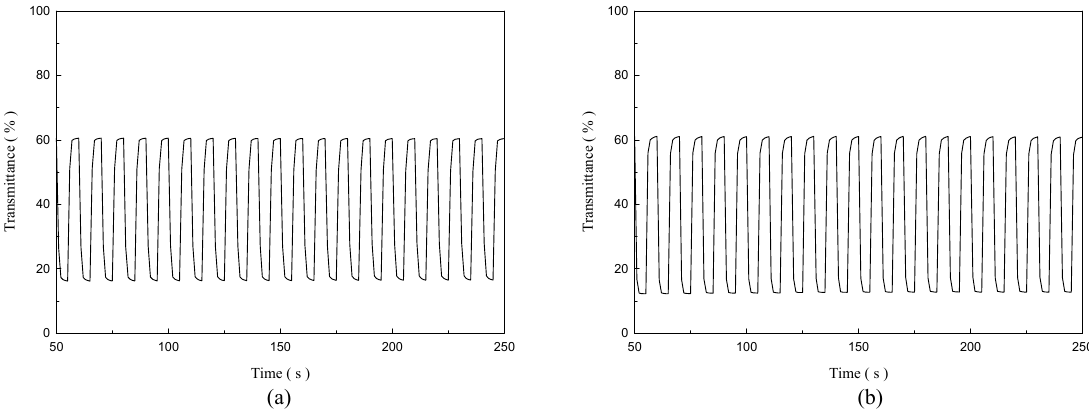
Figure 9. In situ transmittance of: ( a ) P(TTPA- co -DIT)/PProDOT-Et 2 ECD (590 nm); and ( b ) P(TTPA- co -BDTA)/PProDOT-Et 2 ECD (588 nm) as a function of time, the time interval is 5 s. The ECDs were stepped by repeated potential between − 0.2 V and +1.2 V.